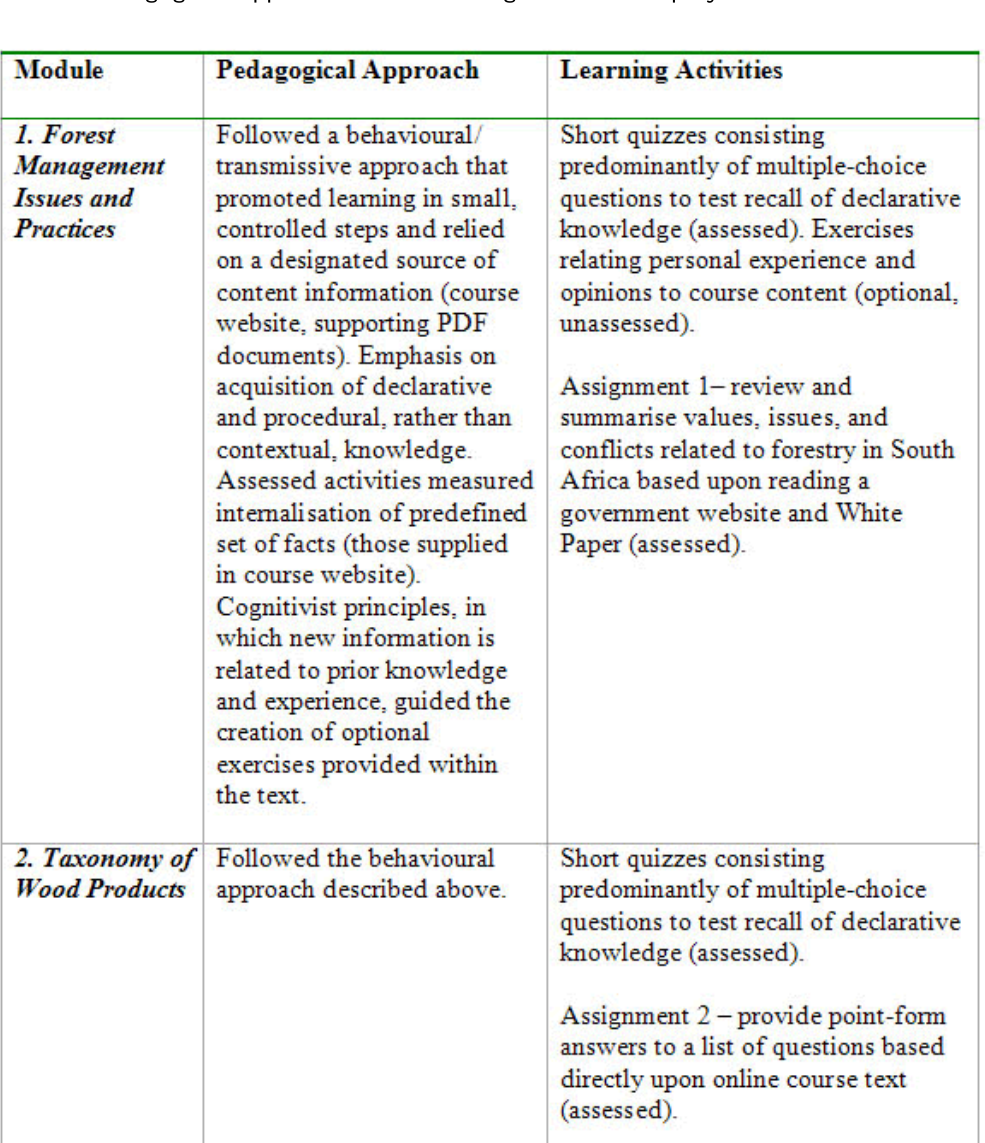
Table 1. Pedagogical Approaches and Learning Activities employed in the